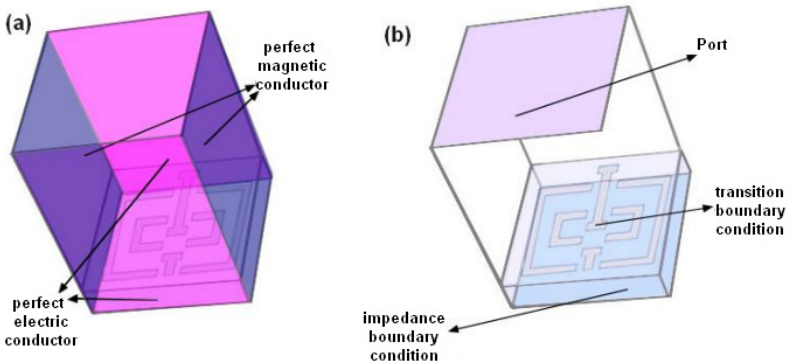
Figure 5. Figure showing the planes of: ( a ) perfect electric conductor, perfect magnetic conductor; ( b ) port, impedance boundary condition, transition boundary condition.